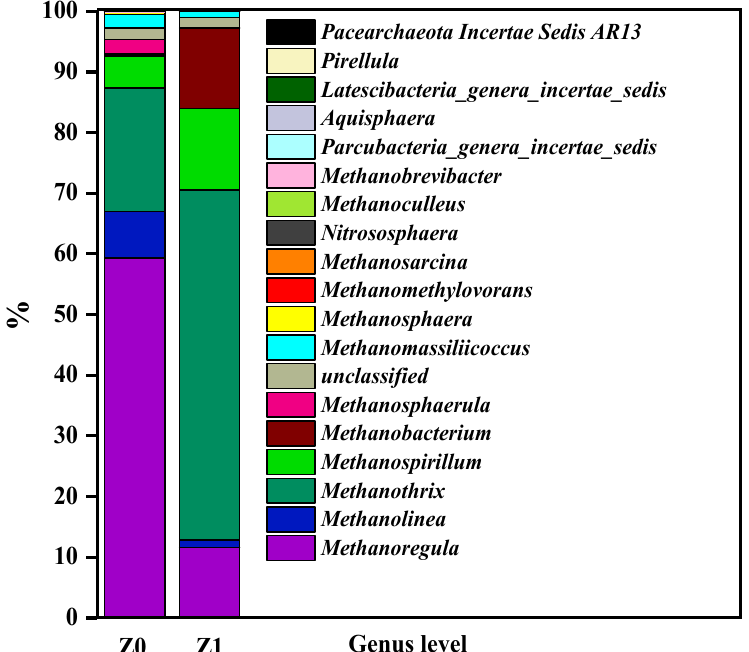
Figure 5. Distribution of the archaea community in the CMABR at genus level classification during anaerobic sludge inoculation and a stable operation. Z0: raw sludge during anaerobic sludge inoculation; Z1: biofilm on fillers during stable operation.